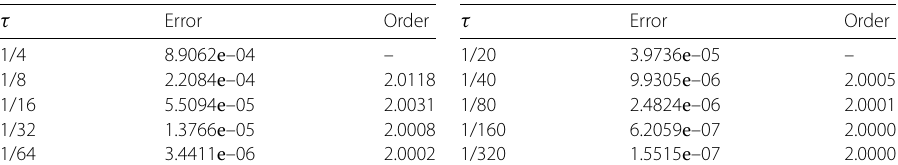
Figure 4 Numerical errors versus τ for Example 2, where α = 0.9